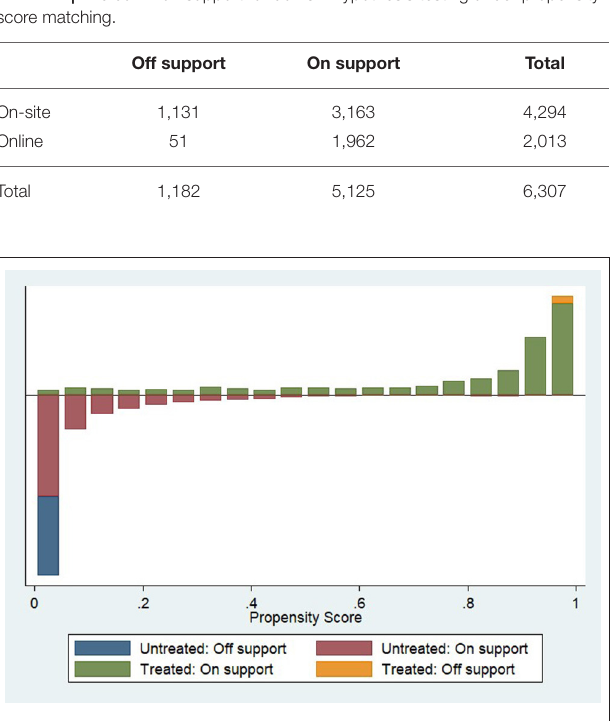
FIGURE 1 | The common range of propensity